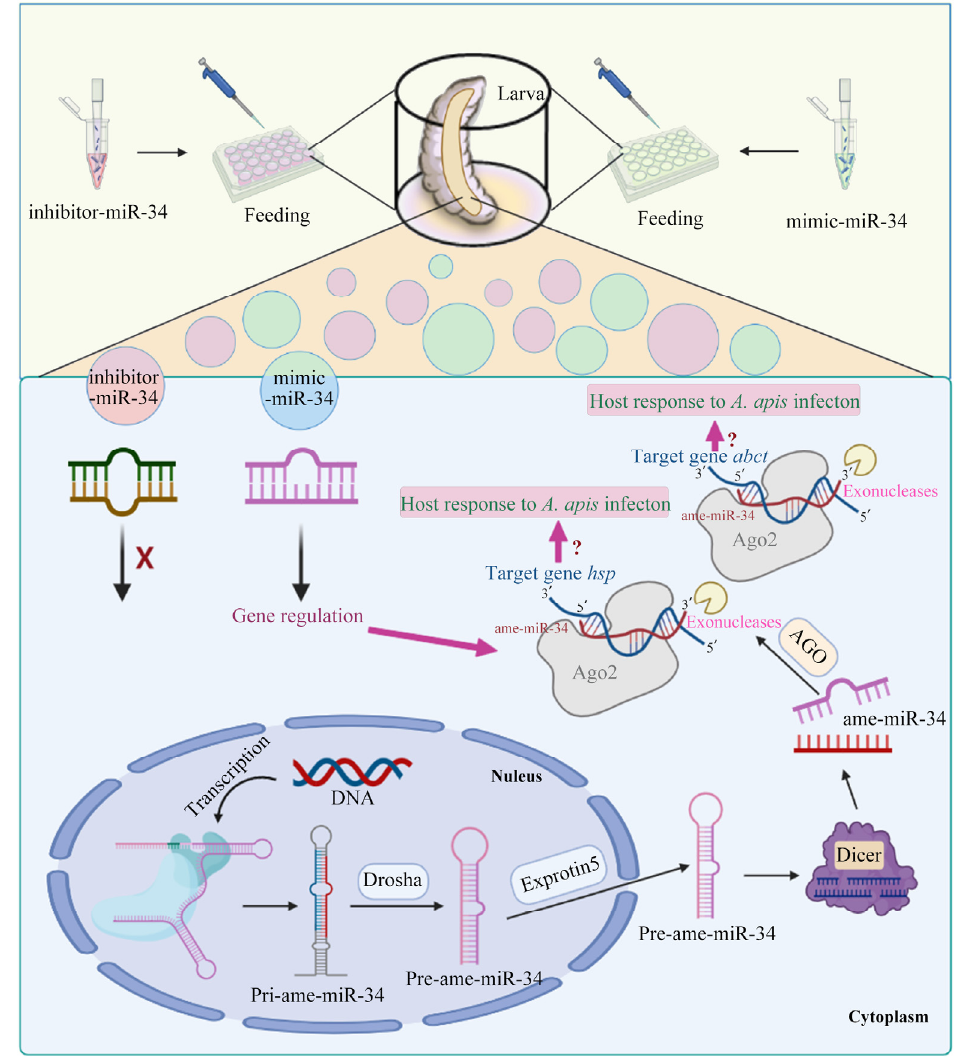
Figure 9. A hypothetical schematic diagram of ame-miR-34-regulated response of A. melliferae to A. apis invasion. A. apis